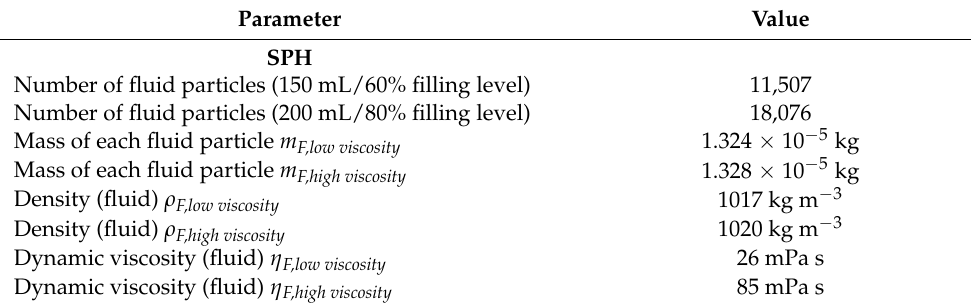
Table 4. Model parameter of the fluid.